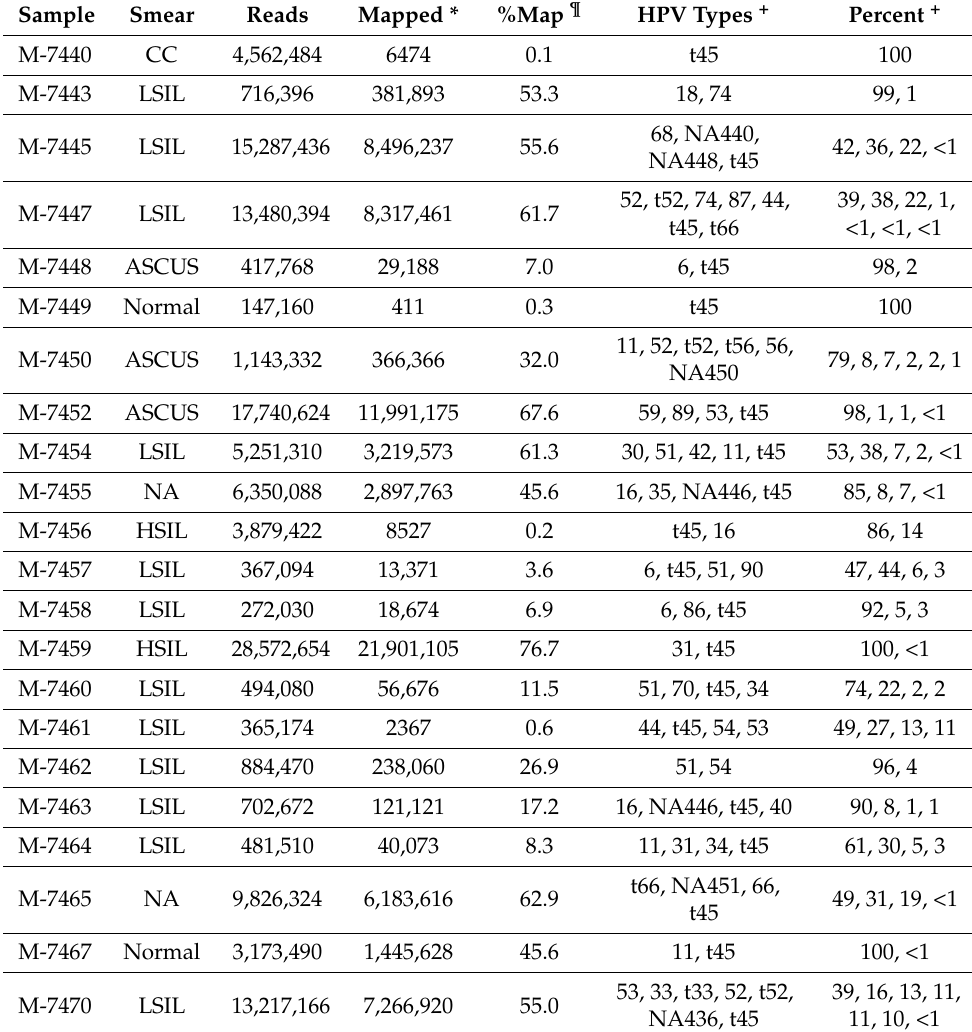
Table 1. Detected human papillomavirus (HPV types per